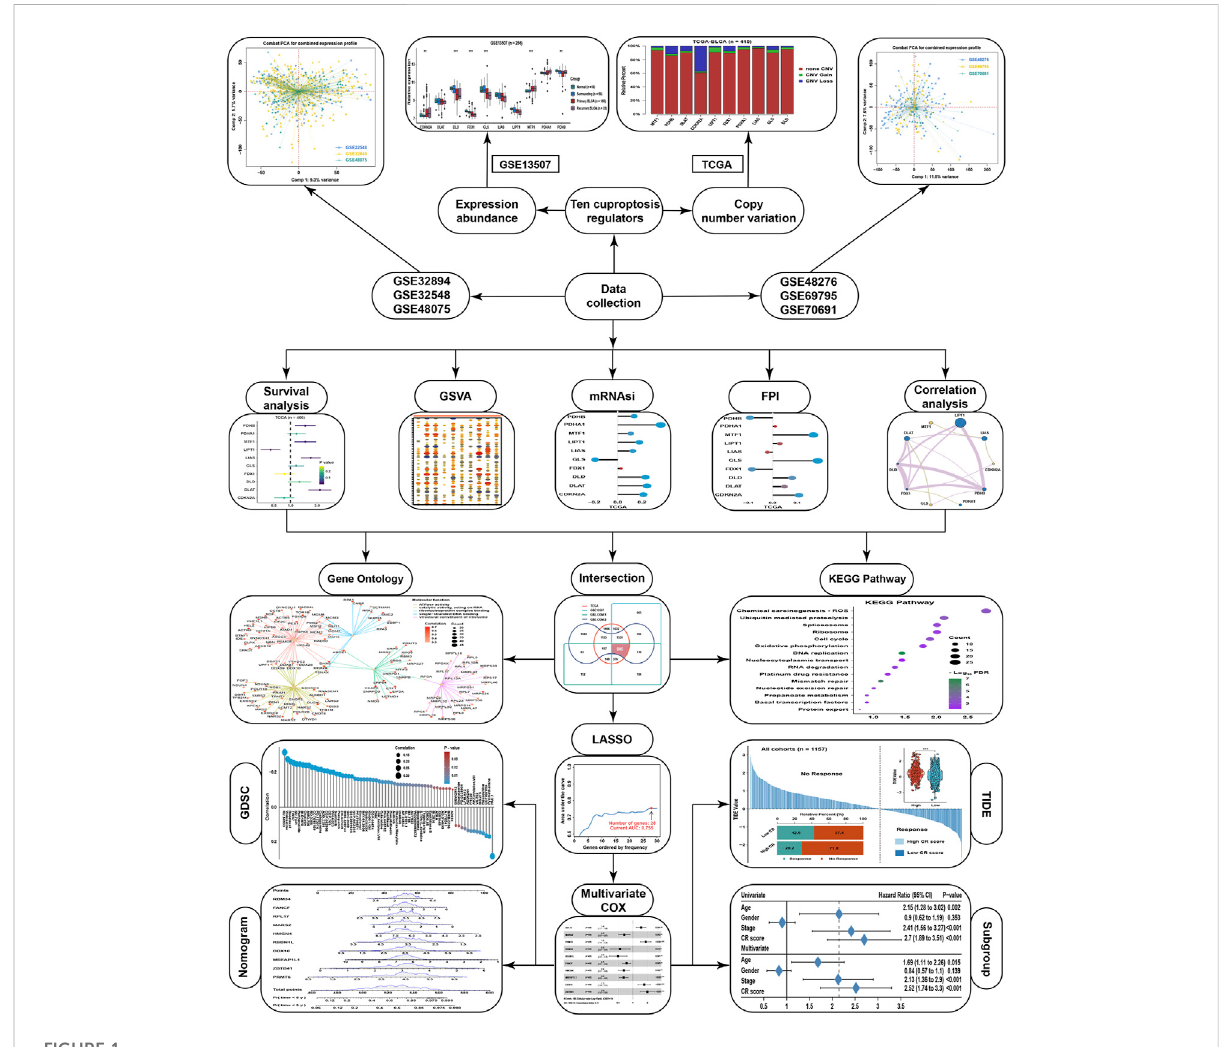
FIGURE 1 The fl owchart of this